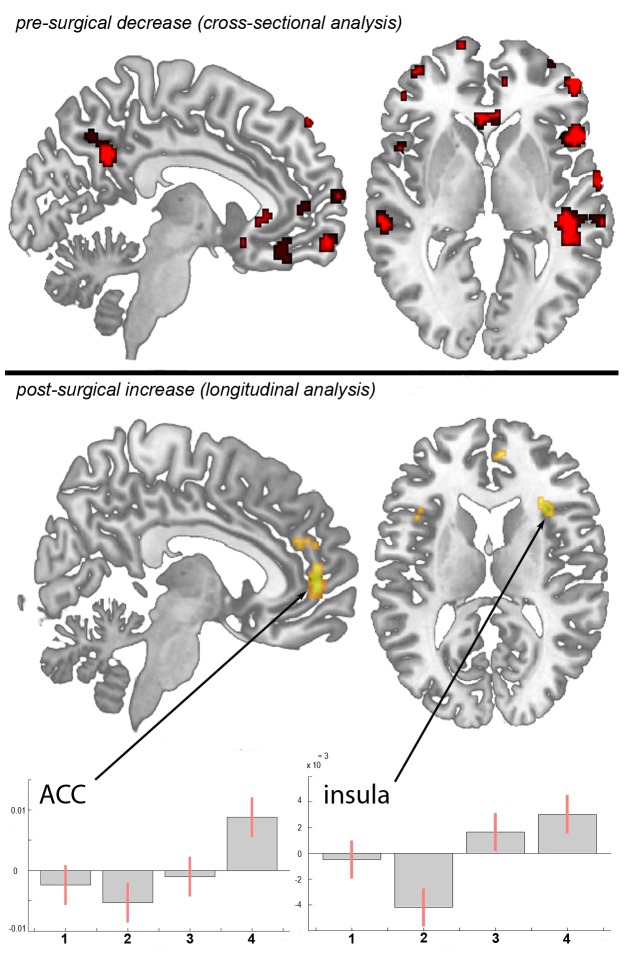
Statistical parametric maps demonstrating the structural differences in gray matter in patients with chronic pain due to primary hip OA compared to controls and longitudinally compared to themselves over time.Significant gray matter changes are shown superimposed in color, cross-sectional data is depicted in red and longitudinal data in yellow. Axial plane: the left side of the picture is the left side of the brain. top: Areas of significant decrease of gray matter between patients with chronic pain due to primary hip OA and unaffected control subjects. p<0.001 uncorrected bottom: Gray matter increase in 20 pain free patients at the third and fourth scanning period after total hip replacement surgery, as compared to the first (preoperative) and second (6–8 weeks post surgery) scan. p<0.001 uncorrected Plots: Contrast estimates and 90% Confidence interval, effects of interest, arbitrary units. x-axis: contrasts for the 4 timepoints, y-axis: contrast estimate at −3, 50, 2 for ACC and contrast estimate at 36, 39, 3 for insula.